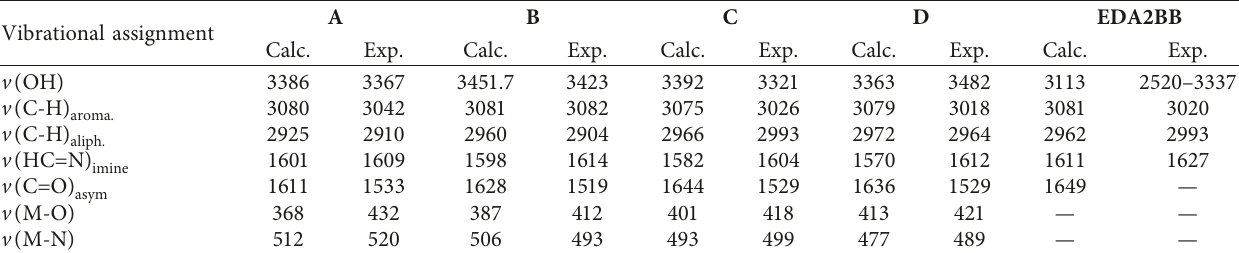
Table 2: Calculated IR frequencies (scaled) at RI-BP86/def2-TZVP level, along with the corresponding experimental IR frequencies for EDA2BB and its metal(II) complexes. Vibrational